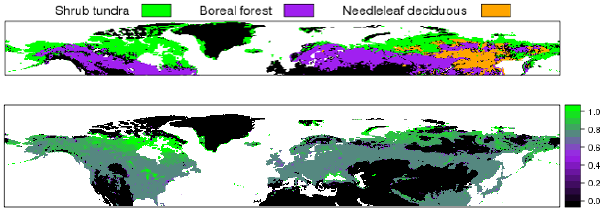
− 1 < 1000m < − 5 ◦ C + 1 None of the above.